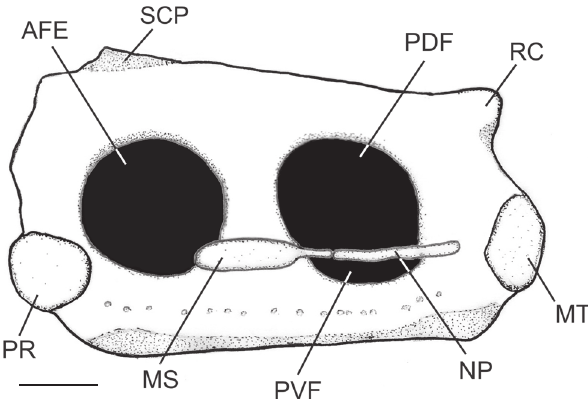
Figure 13. Lateral view of scapuloracoid of D. mennii (UERJ 1008). (AFE), anterior fenestra, (MS) mesocondyle, (MT) metacondyle, (NP) neopterygial process, (PDF) posterior dorsal fenestra, (PR) procondyles, (PVF) posterior ventral fenestra, (RC) rear corner, (SCP) scapular process. Scale bar: 20